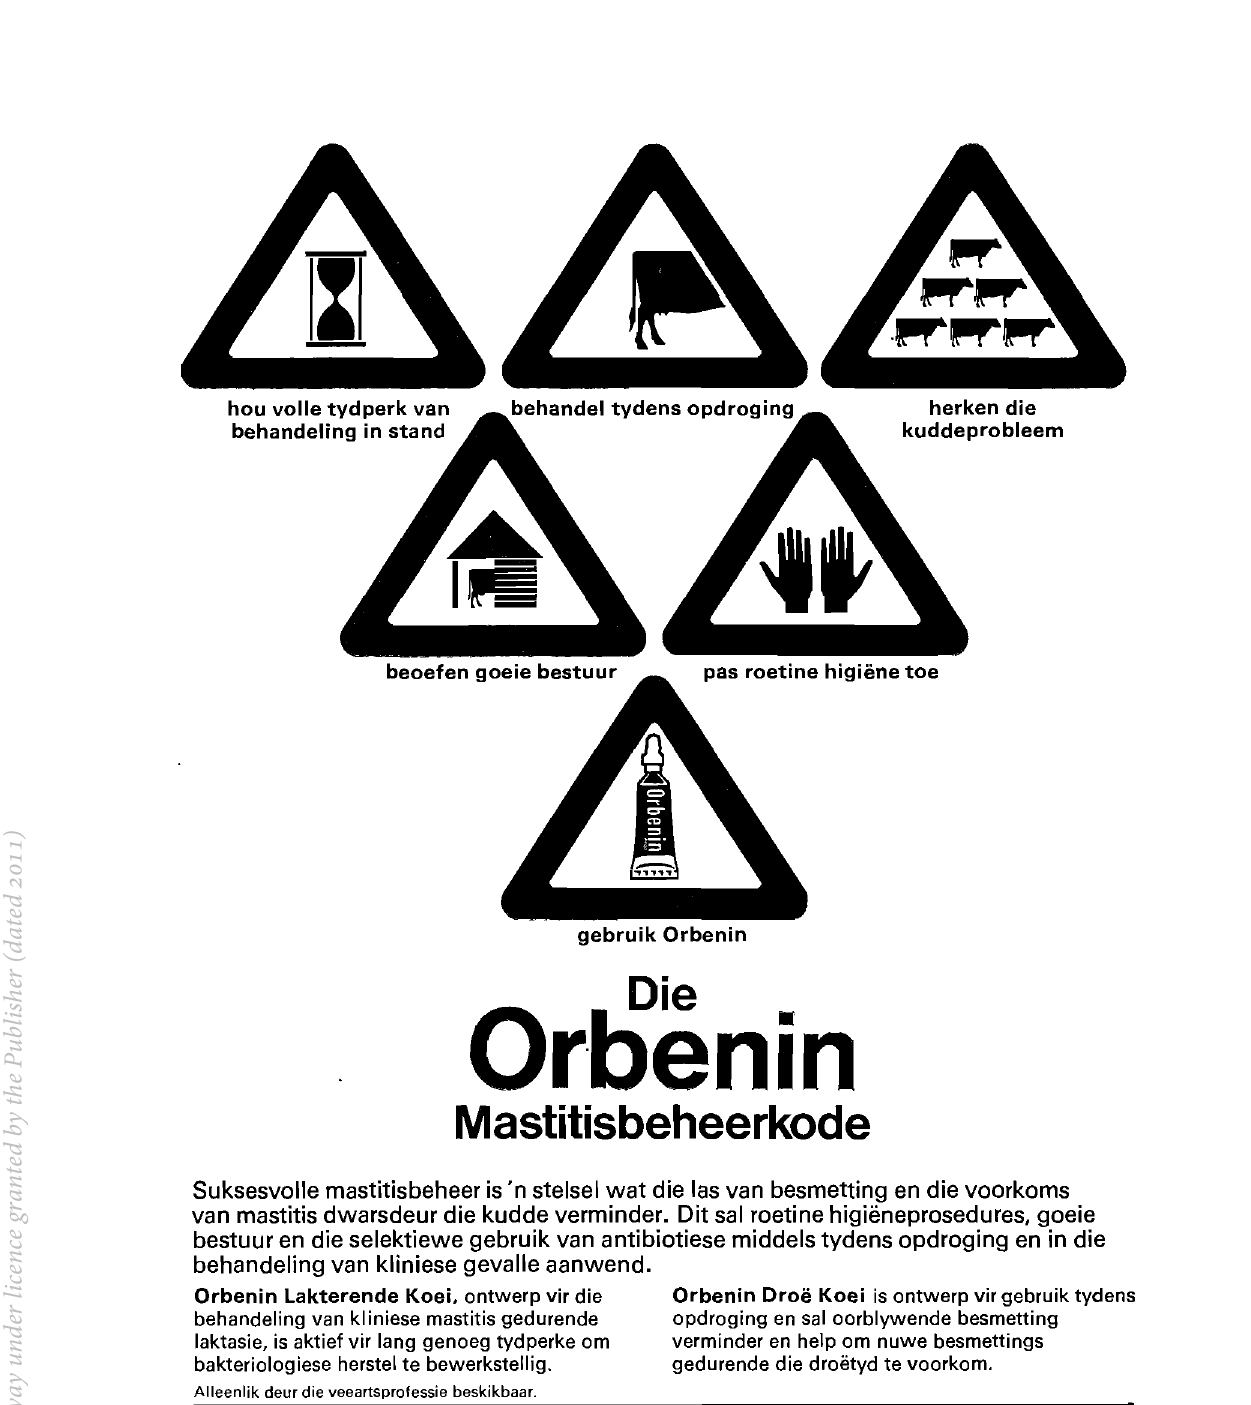
Suksesvolle mastitisbeheer is 'n stelsel wat die las van besmetting en die voorkoms van mastitis dwarsdeur die kudde verminder. Dit sal roetine higieneprosedures, goeie bestuur en die selektiewe gebruik van antibiotiese middels tydens opdroging en in die behandeling van kliniese gevalle aanwend. Orbenin Lakterende Koei. ontwerp vir die behandeling van kliniese mastitis gedurende laktasie, is aktief vir lang genoeg tydperke om bakteriologiese herstel te bewerkstellig. Alleenlik deur die veeartsprofessie beskikbaar.